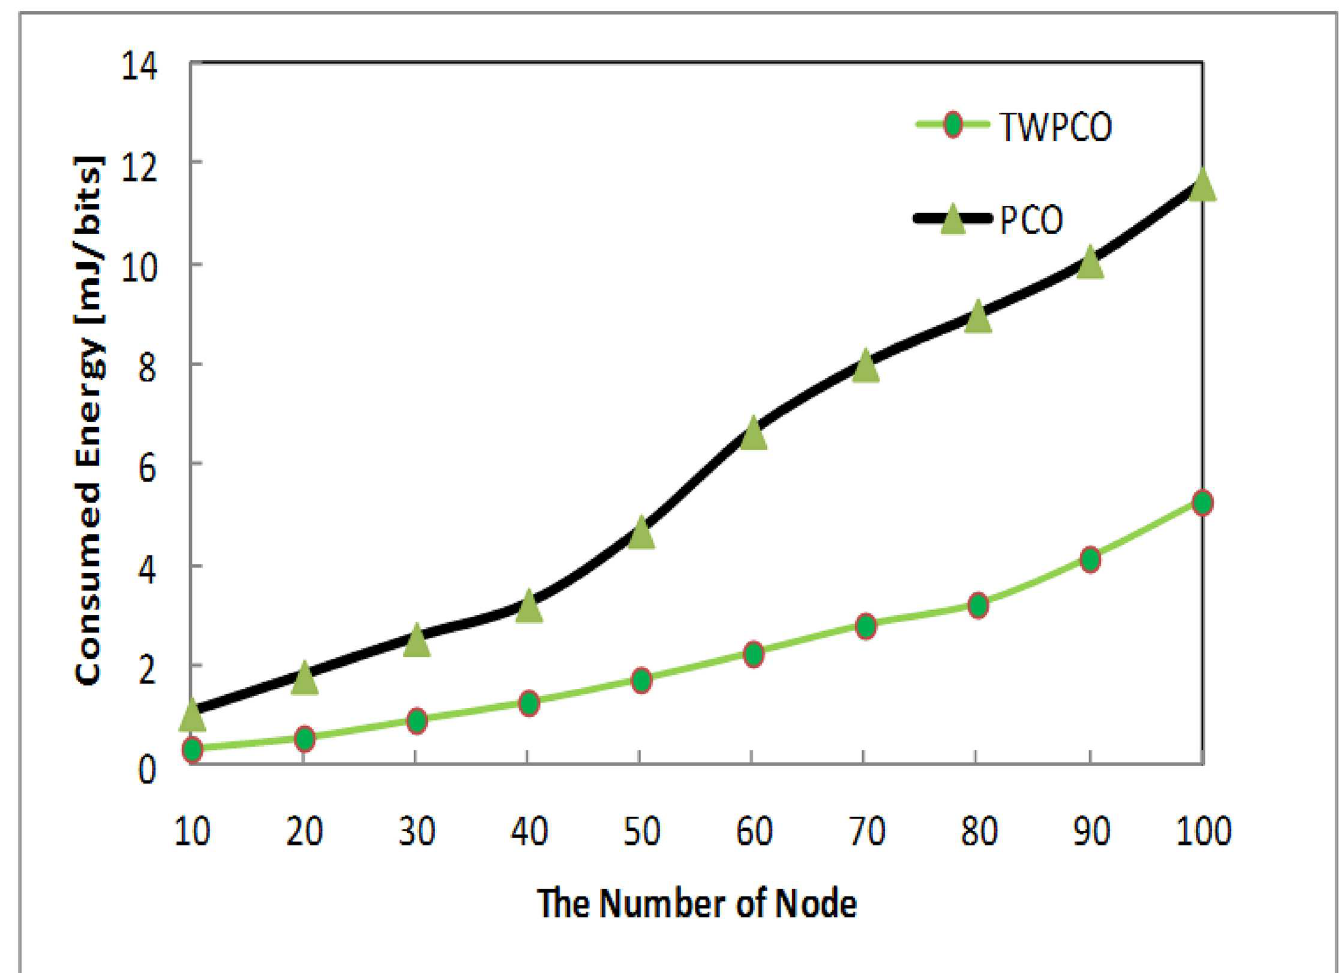
Fig 15. Energy efficiency ratio based on the number of